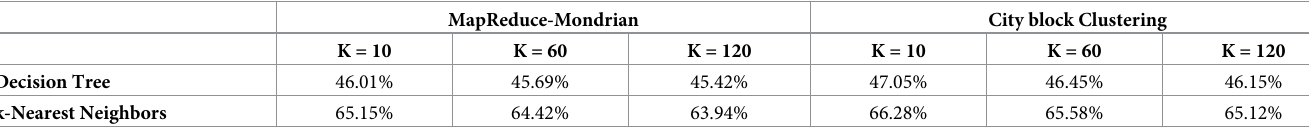
MapReduce-Mondrian